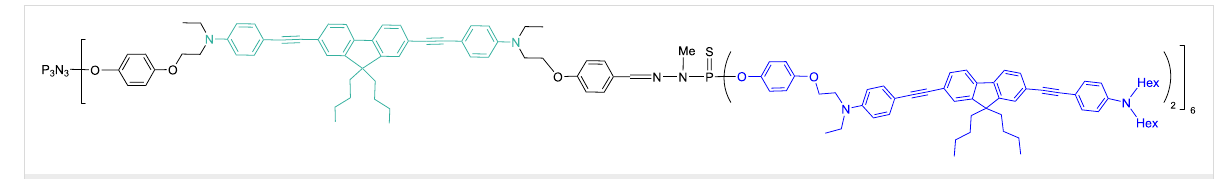
Figure 8: Double layer fluorescent dendrimer.